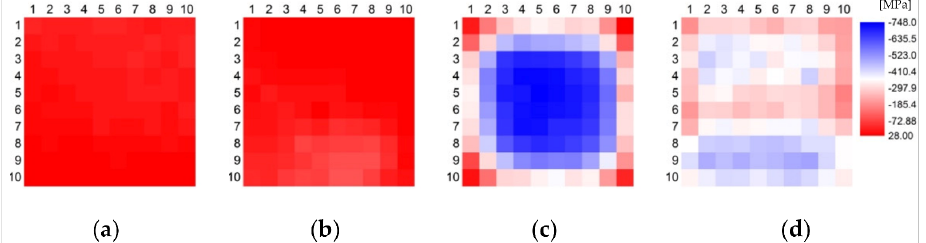
Figure 11. Stress distribution at 20 ◦ C, on ( a ) Si_Unmounted chip, ( b ) A_AuSn_p, ( c ) A_AuS, and ( d ) B_AuSn samples.